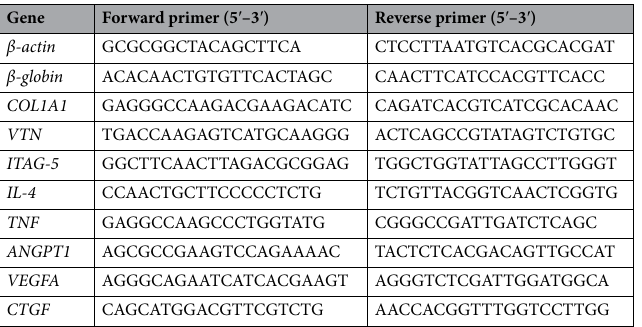
Table 1. Name of target genes and respective primer sets used to quantify mRNA levels in